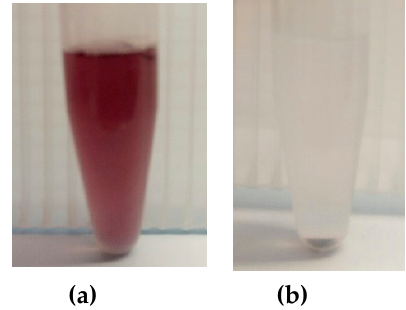
Figure 2. Separation of gold nanorods (AuNRs) dispersion from CTAB and by-products: ( a ) before centrifugation; ( b ) after centrifugation.